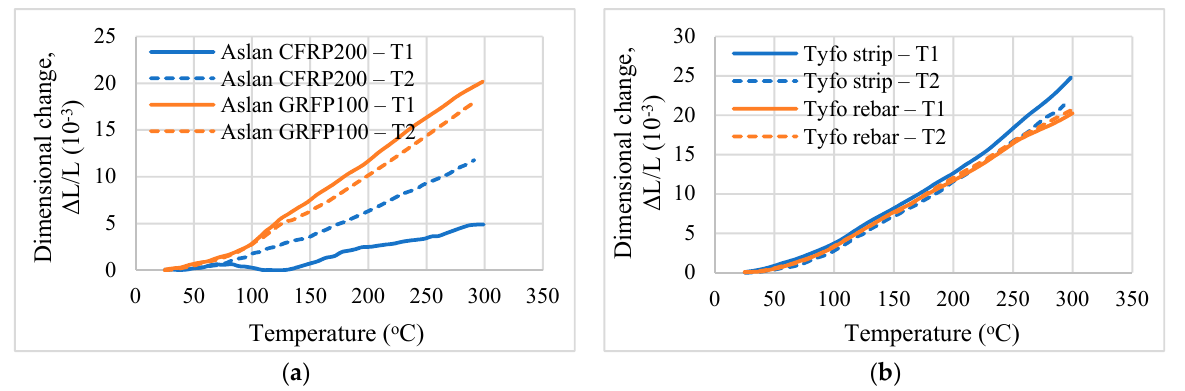
Figure 8. Thermal expansion of NSM FRP specimens in the transverse direction. ( a ) Thermal expansion of Aslan GFRP and Aslan CFRP. ( b ) Thermal expansion of Tyfo rods and Tyfo strips.